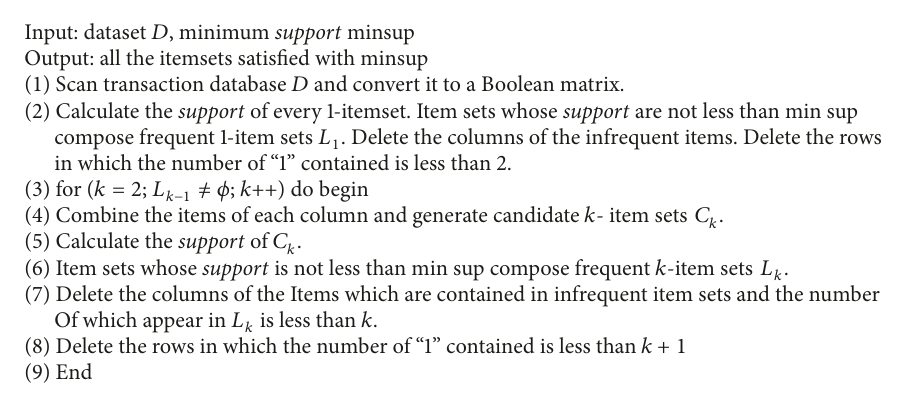
Algorithm 1: The procedure of the improved algorithm based on matrix.